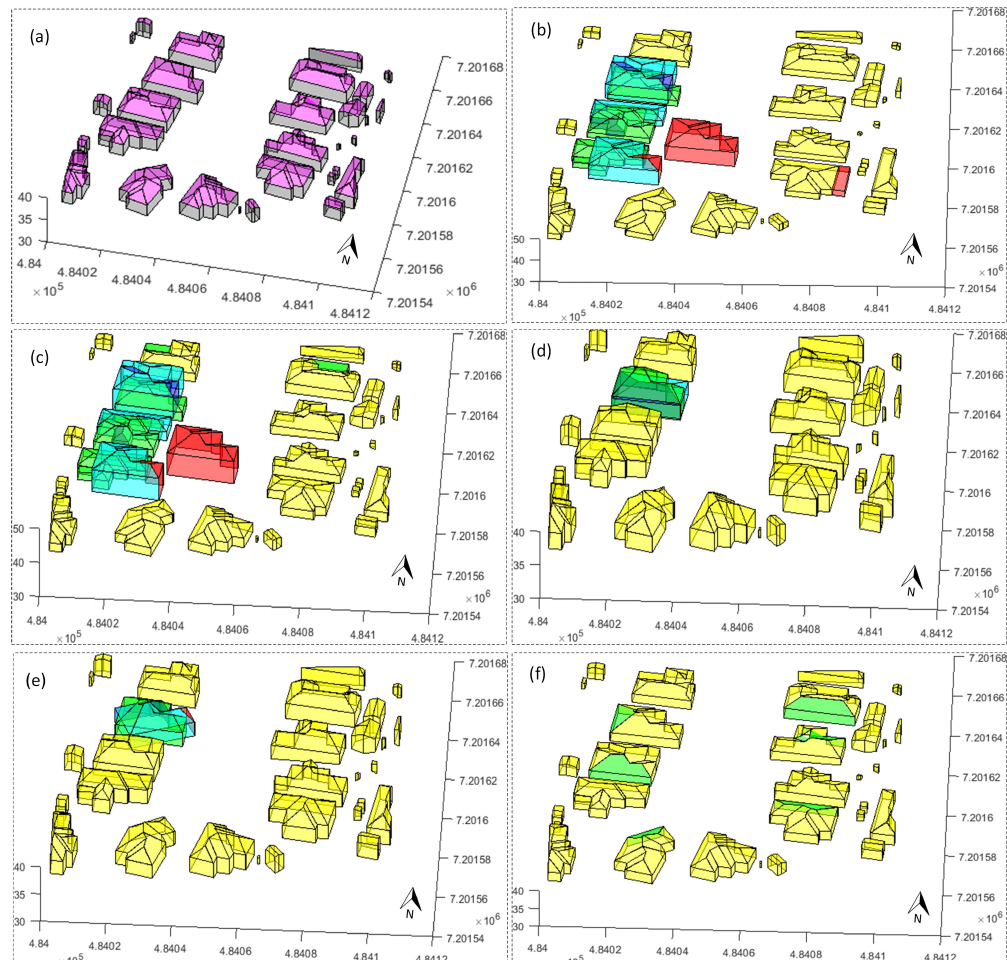
Figure 19. Selected qualitative results of Hervey Bay (HB) reference site after applying the proposed change detection method: ( a ) HB reference models; and change detections in test sites: ( b ) HB(17); ( c ) HB(26); ( d ) HB(29); ( e ) HB(30); and ( f ) HB(31) (Table 1). The reference models in ( a ) are shown in pink and grey colours. In the change detection results ( b – f ), the unchanged, new, modified, partially-modified and demolished planes are marked by yellow, red, blue, cyan and green colours,